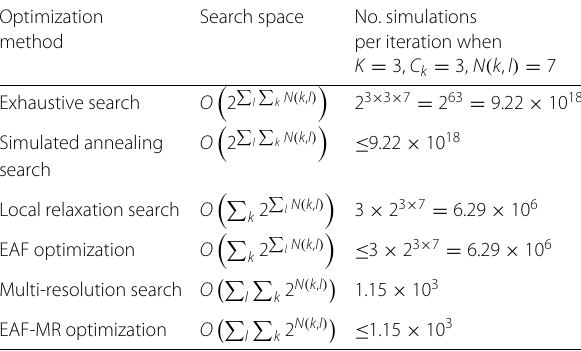
Table 2 Search space of optimization methods Optimization Search